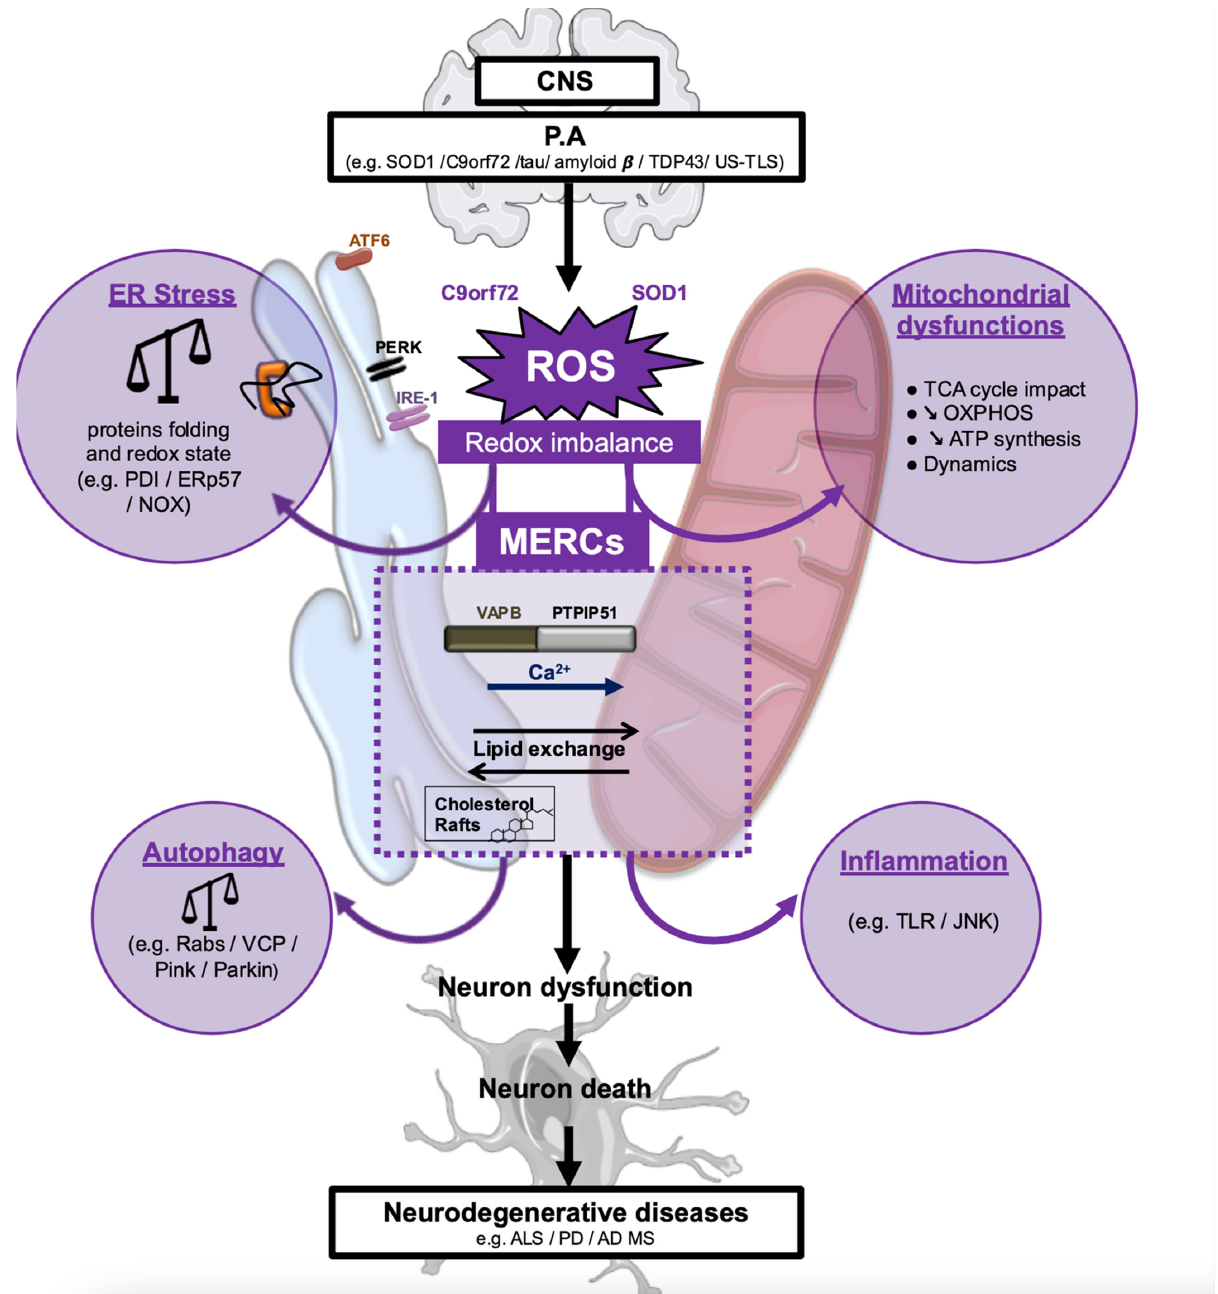
Figure 1. Overview on the convergence of pathological mechanisms on the mitochondria-ER contacts (MERCs). Protein aggregates (P.A.) cause reactive oxygen stress, which modulates MERCs and disrupts their physiological control of mitochondrial bioenergetics, ER stress, autophagy, and inflammation, resulting in the neurodegenerative pathology.